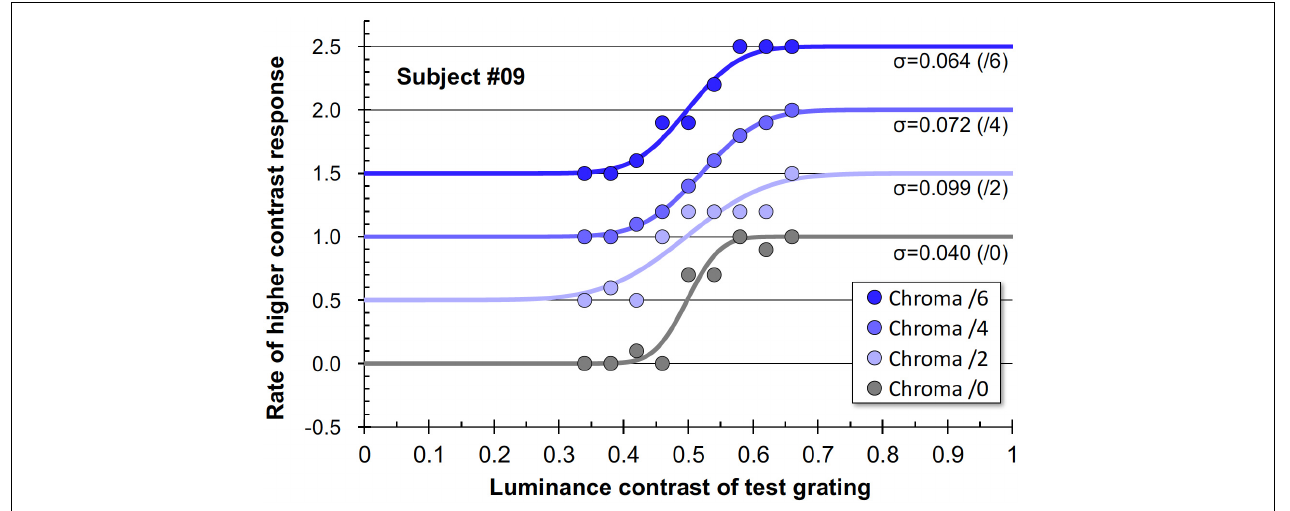
FIGURE 11 | Example data and psychometric functions for one subject under four Chroma conditions. The ordinate was defined as the data for Chroma /0 condition. Other data were vertically shifted in multiples of 0.5 to clarify. The standard deviations ( σ ) for all conditions are shown in the panel.